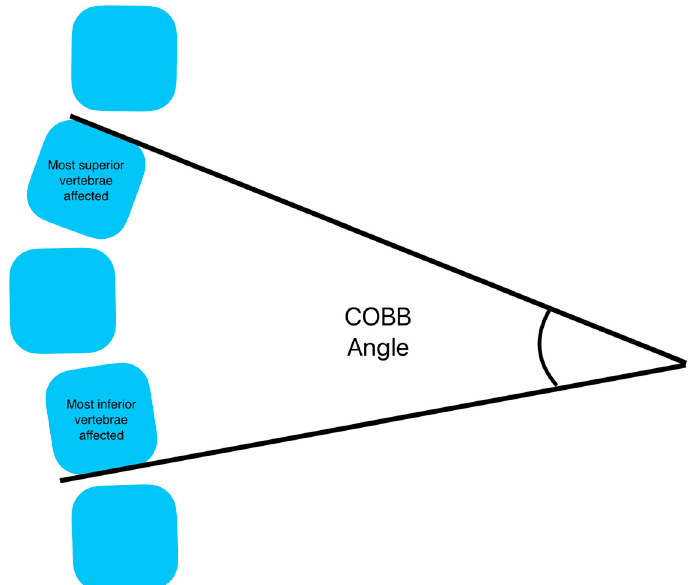
Figure 2. Image of Cobb angle measurement .